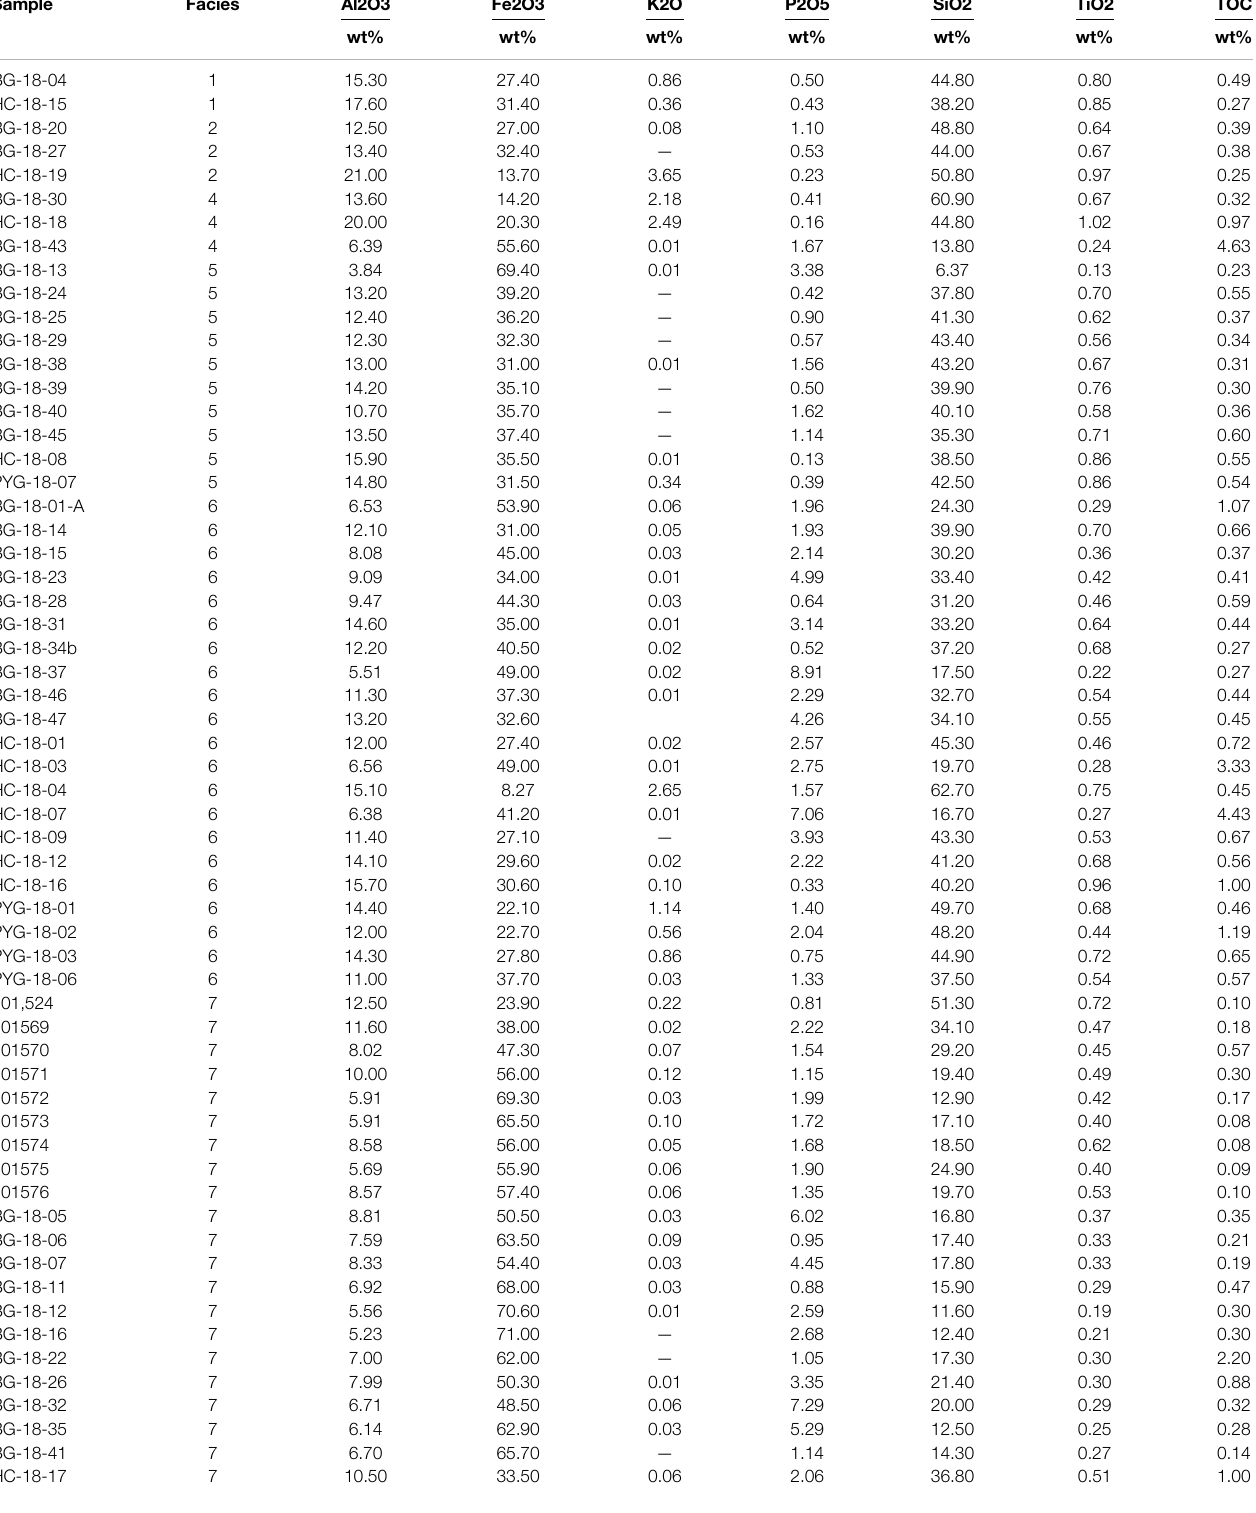
TABLE 1 | Major element and total organic carbon (TOC) concentrations in lithofacies of the Hen-dy-Capel Ironstone Member, Tygarn Formation.